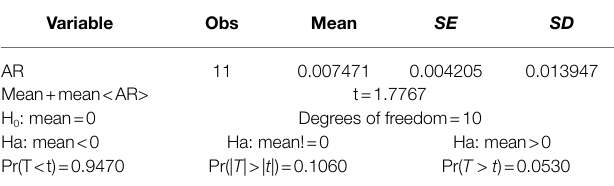
TABLE 18 | Changes in abnormal